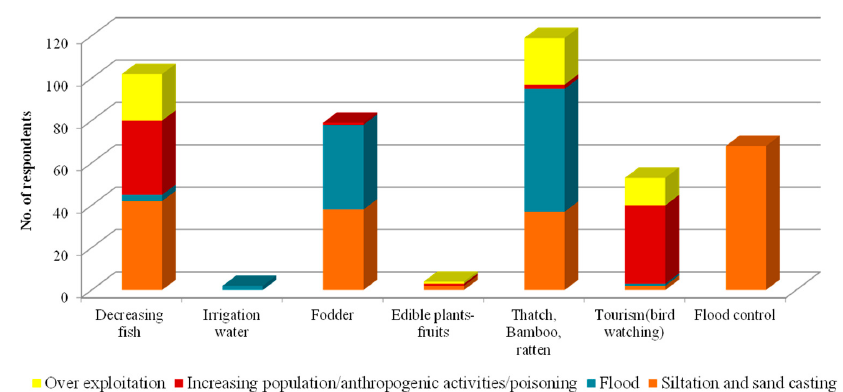
Figure 6. Linkages between drivers of change and changes in availability of ecosystem services, derived through household surveys.